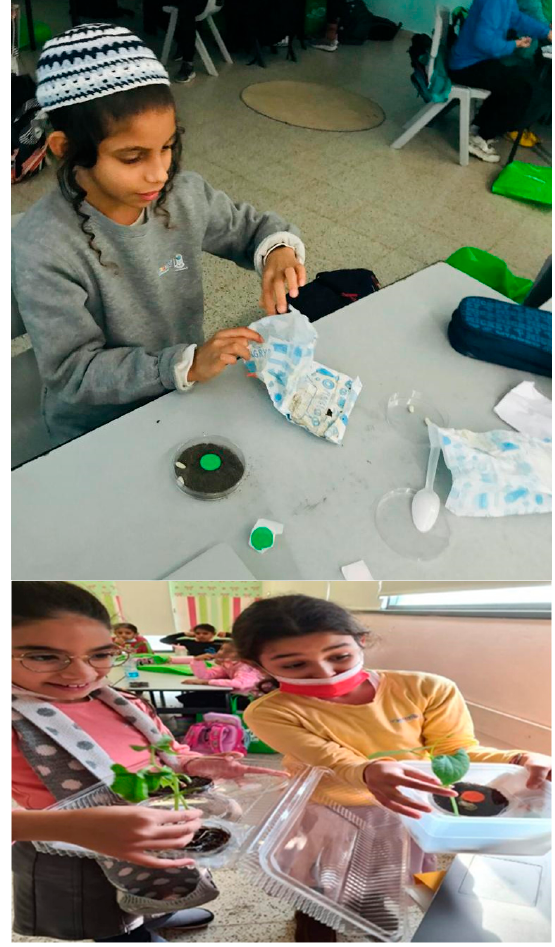
Figure 2. The pupils during the bean experiment .